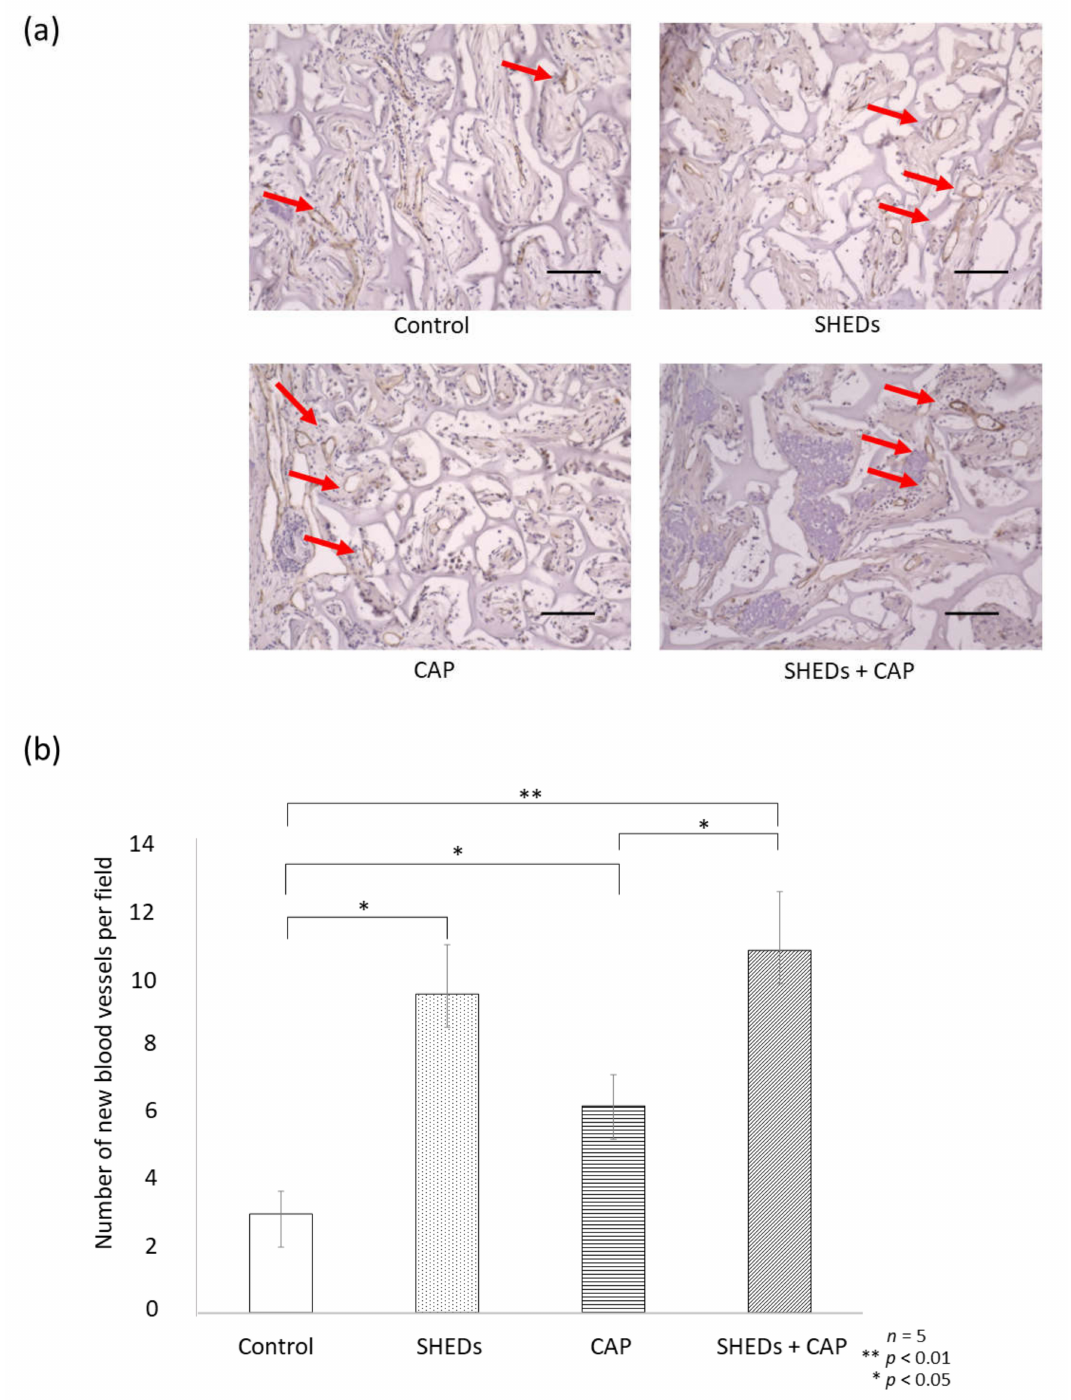
Figure 5. IHC analysis of CD31. ( a ) IHC analysis of CD31 expression revealed new blood vessels (indicated using red arrows) in the SHEDs, CAP, and SHEDs + CAP groups compared to the control group. ( b ) SHEDs + CAP had significantly more blood vessels than the CAP group and the control group. There was no significance difference in the number of blood vessels between the SHEDs and SHEDs + CAP groups. n = 5 for each group, ** p < 0.01, * p < 0.05. CD31 scale bar = 100 µ